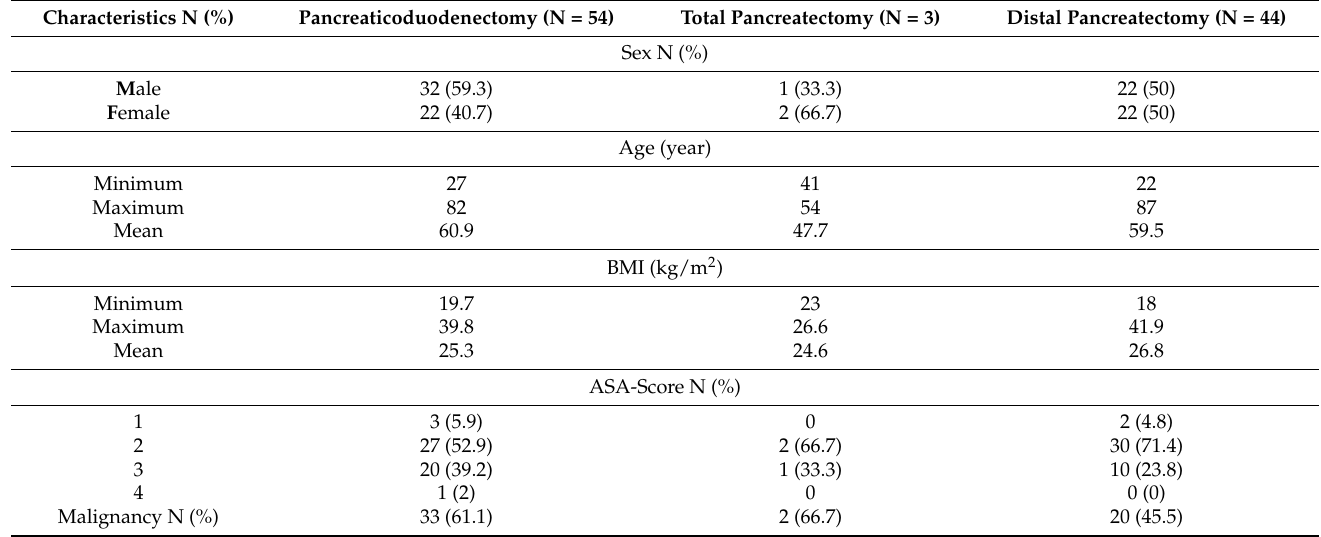
Table 1. Patient’s demographics.